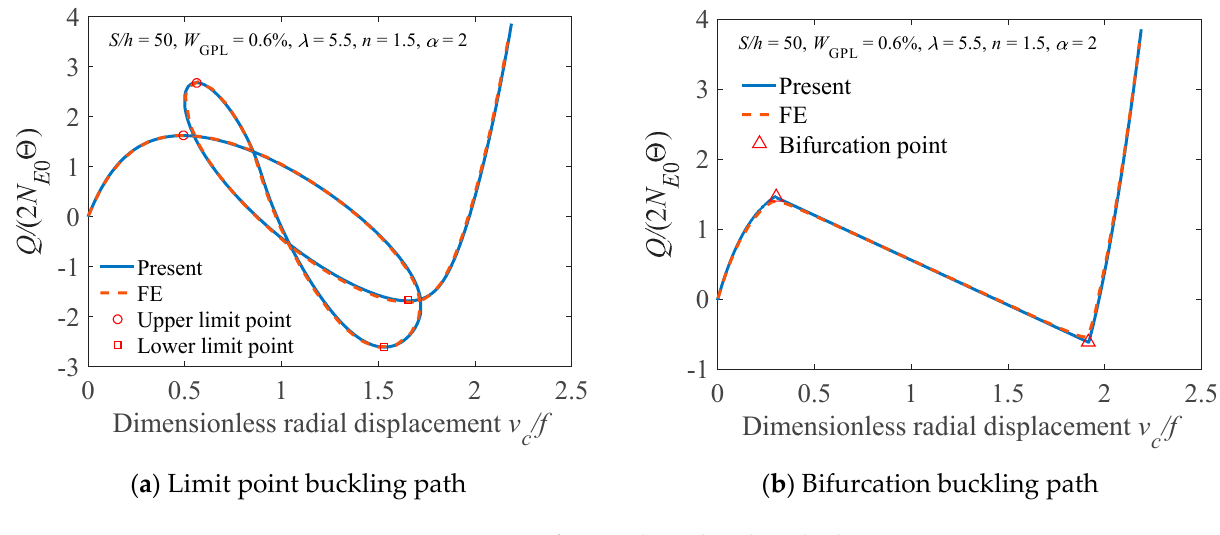
Figure 4. Comparison of FE results and analytical solutions.